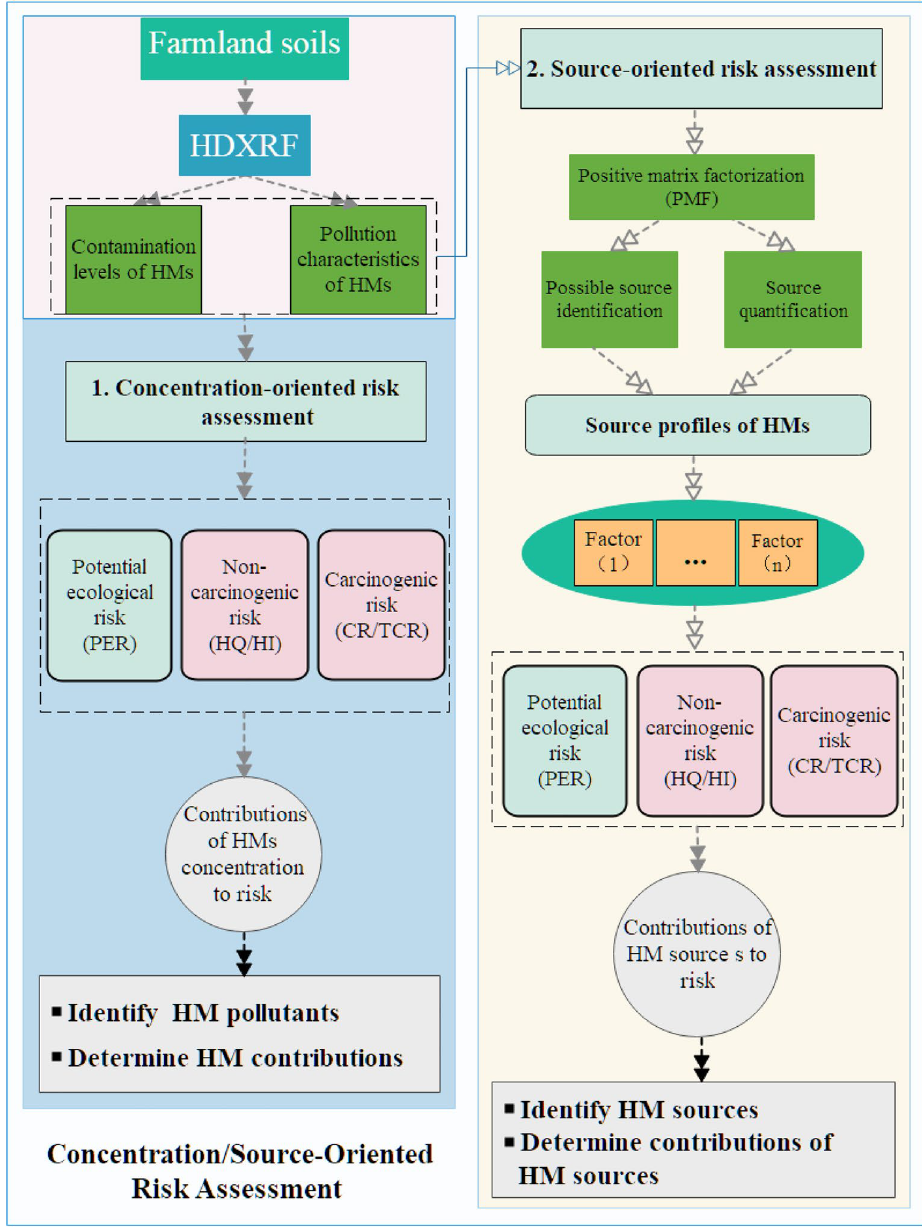
Figure 1. Framework of the concentration/source-oriented risk assessment approach used in this